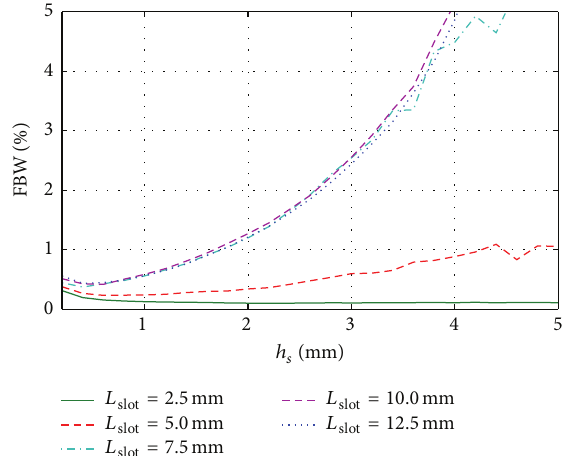
Figure 5: Dependence of the substrate height on the fractional bandwidth for various slot